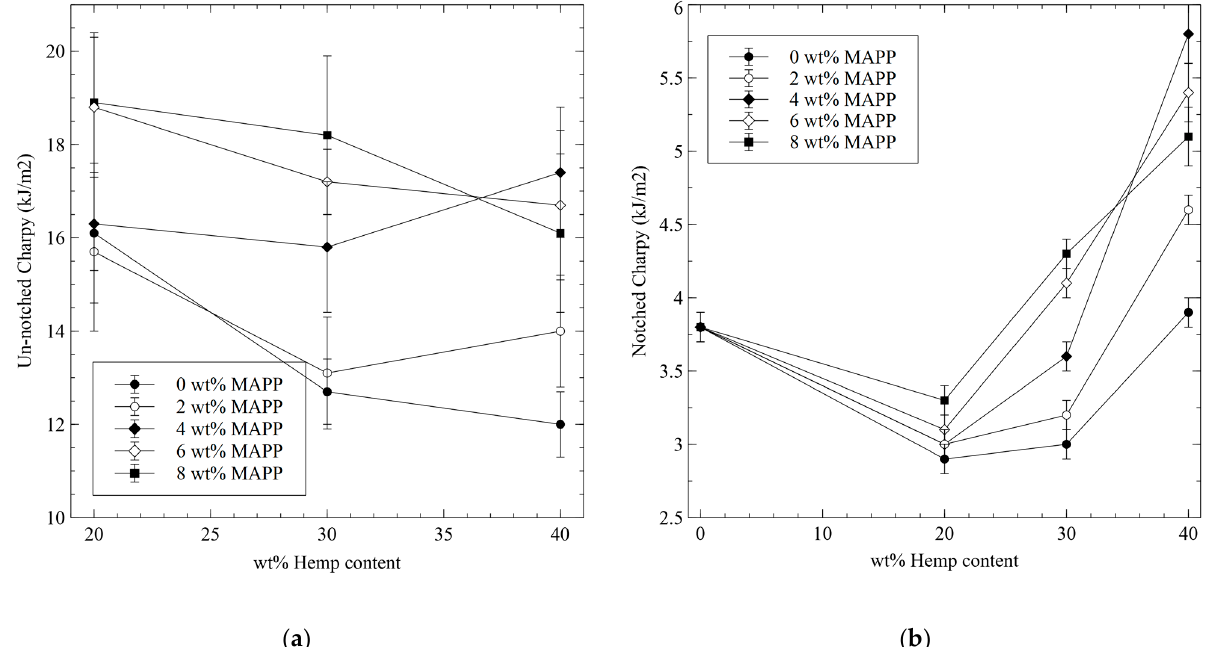
Figure 2. Evolution of the impact strength against MAPP and HS contents: ( a ) for un-notched Charpy specimens; ( b ). for notched Charpy specimens.